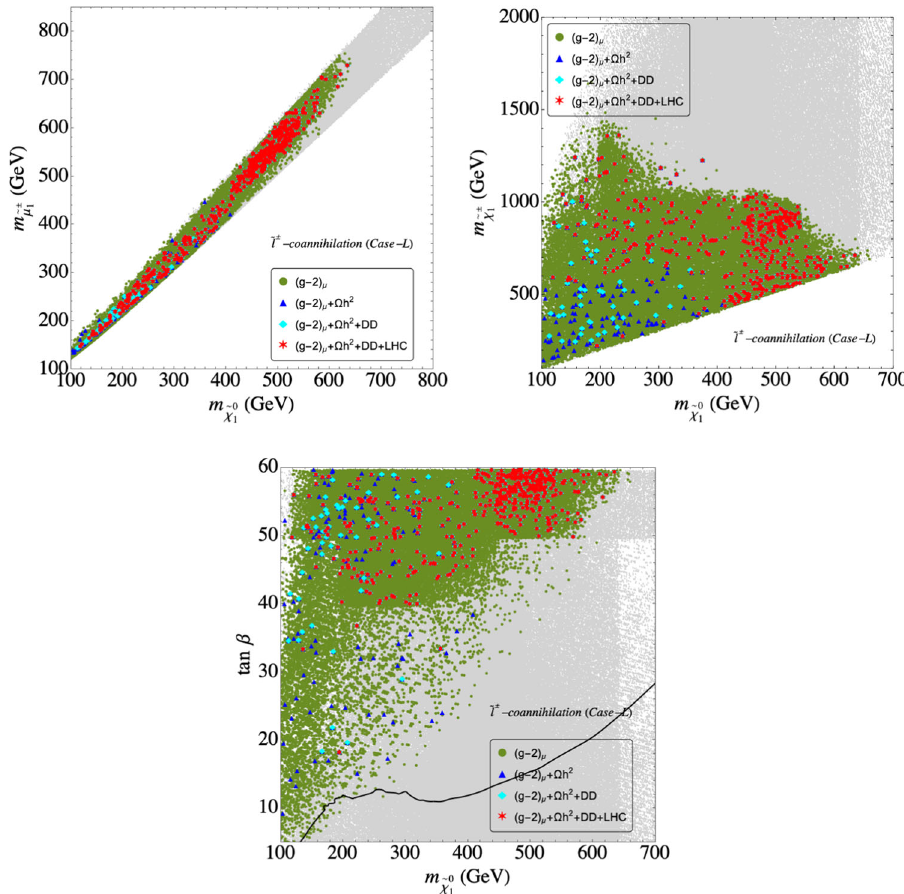
Fig. 2 Results in the ˜ l ± -coannihilation Case-L: m ˜ χ 0 – m ˜ plane (upper left), l 1 1 m ˜ χ 0 – m ˜ χ ± plane (upper right), 1 1